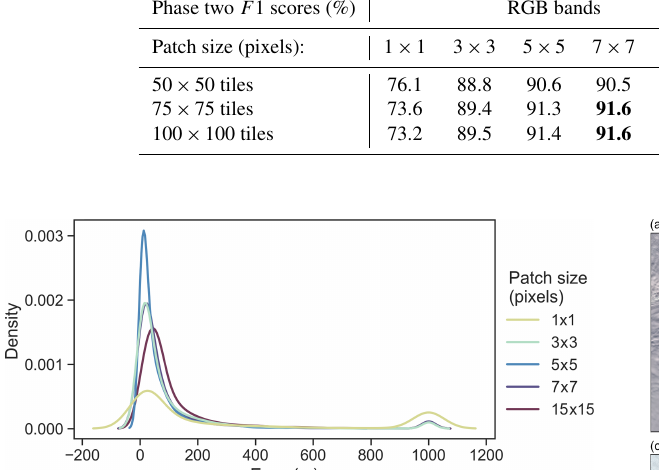
Figure 7. A kernel density estimate (KDE) plot of the full error distribution for all calving front predictions derived from all test sites using classifications produced with optimal parameters. Error values above 1000m are grouped into a single bin to reduce tail length and show a second peak which represents catastrophic errors in calving front prediction. Note that low calving front errors occur most with 5 × 5 patches, followed by 7 × 7 and 3 × 3 patches, with the highest error occurring for the pixel-based approach.